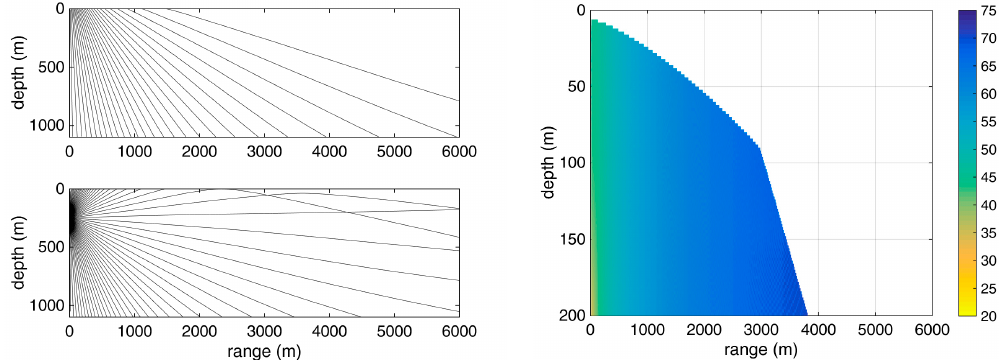
Figure 4. Predicted geometry of direct ( bottom left ) and surface-reflected ( top left ) acoustic rays from a source at a depth of 250 m in the sound speed profile of Figure 3. Area where the TDOA between direct and surface-reflected arrivals is larger than 7 ms ( right ). The colors in that area denote the ray-theoretic transmission loss (TL)—scale on the right in dB—without absorption.